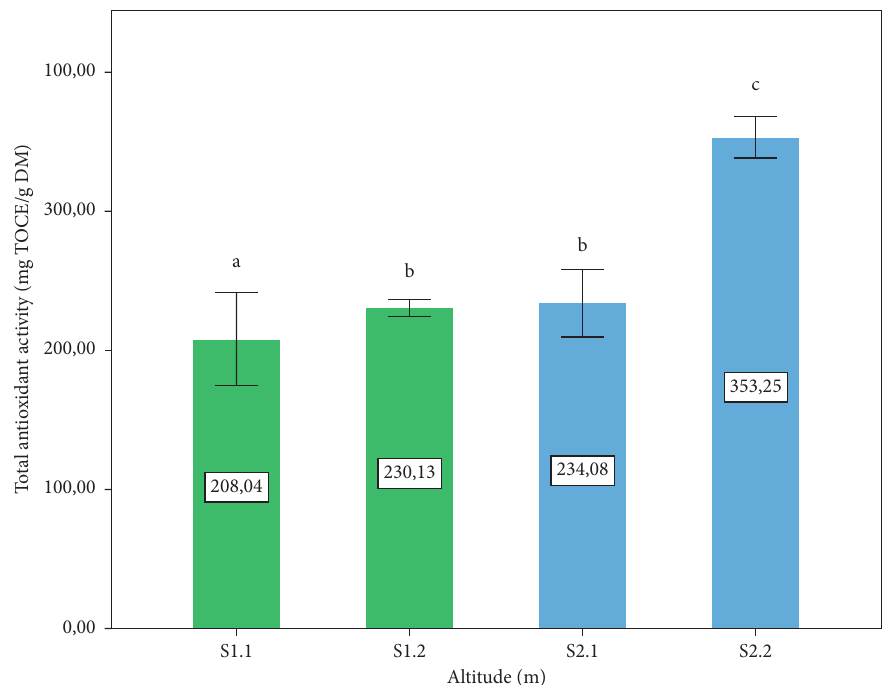
Figure 8: Total antioxidant activity of P. lentiscus L. leaves extract expressed in mg equivalent α -tocopherol. Vertical bars represent the standard deviation of the mean. Values not sharing a common letter indicate a significant difference at p ≤ 0 . 05, based on the SNK test. TOCE: α -tocopherol equivalent. S: site, S1.1 � 1400m, S1.2 � 1120, S2.1 � 780m, S2.2 � 720m S: site, S1.1 � 1400m, S1.2 � 1120, S2.1 � 780m, S2.2 �